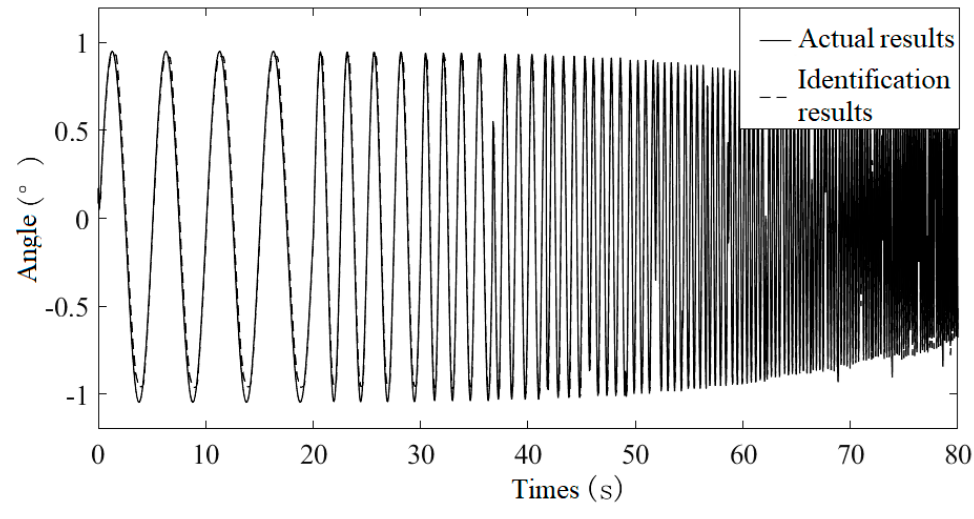
Figure 2. Comparison of identification results.